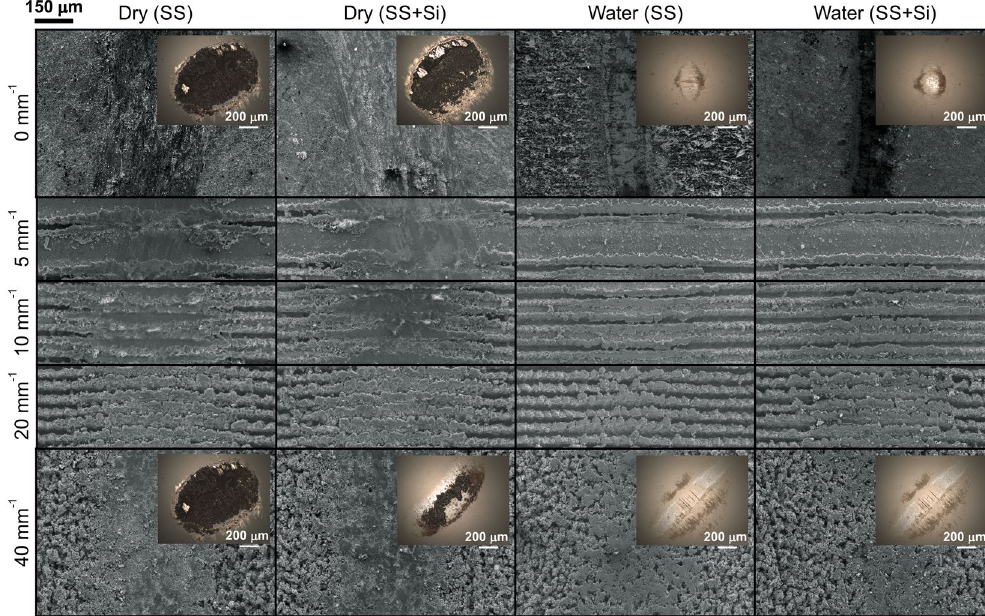
Figure 6. SEM images of selected wear tracks obtained in dry and water environments. The insets in the images show the worn surface of the sliding